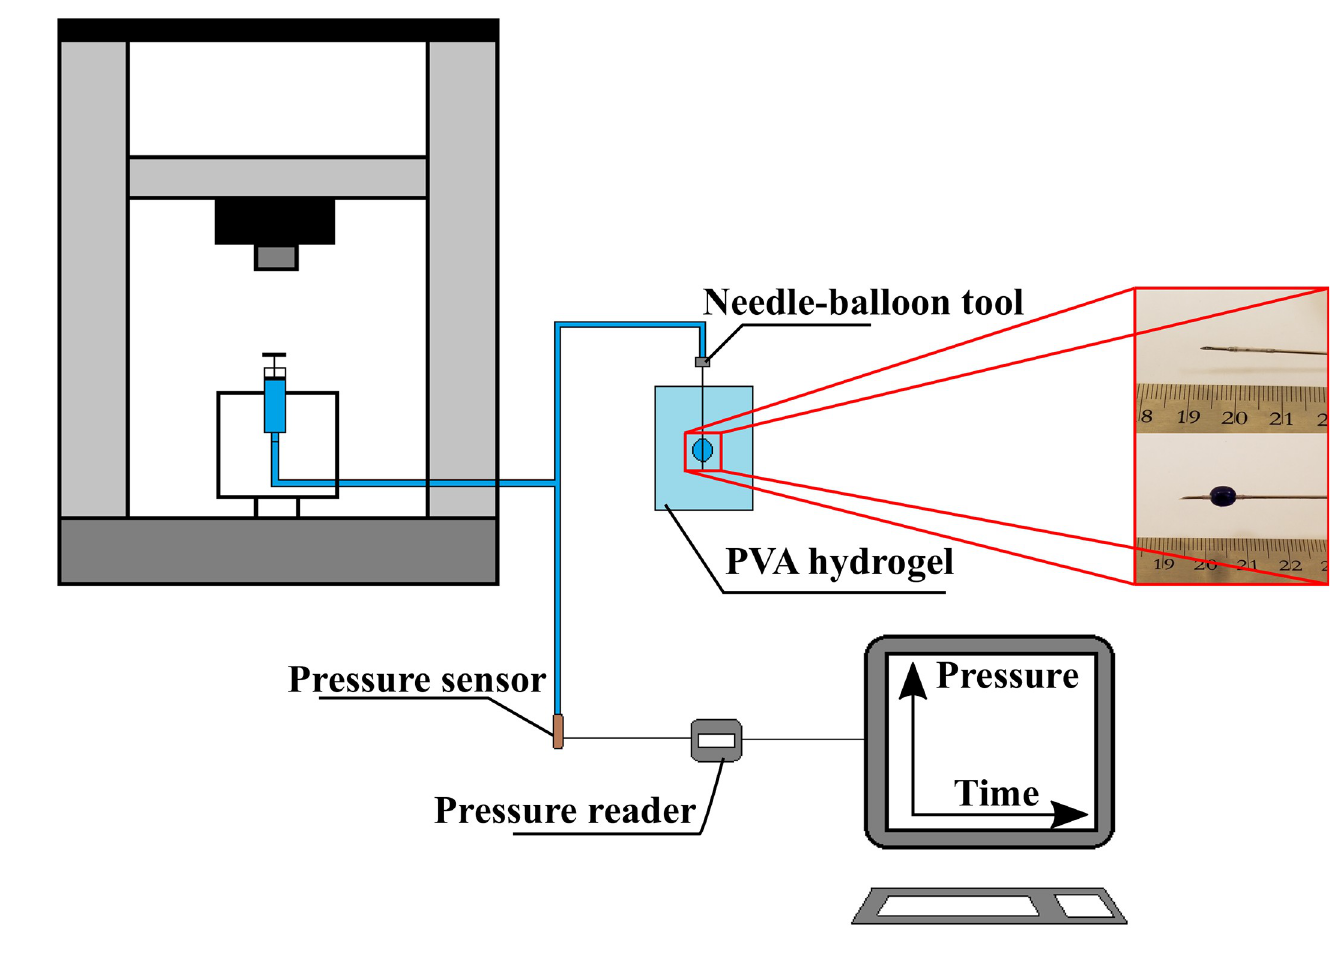
Fig 2. The loading set up for the cavity expansion